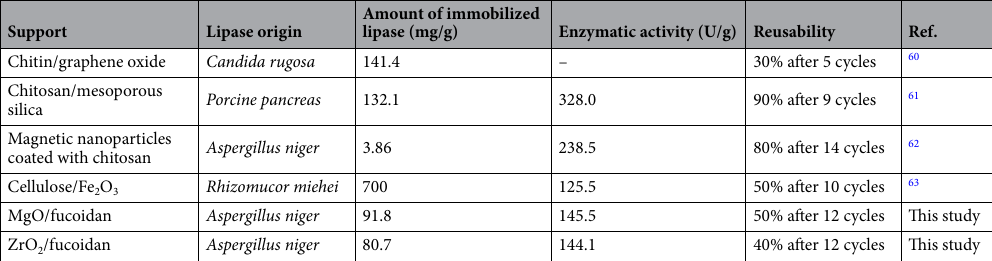
Table 2. Comparison of the present results with literature data on lipase immobilization on various polysaccharide-based hybrids.